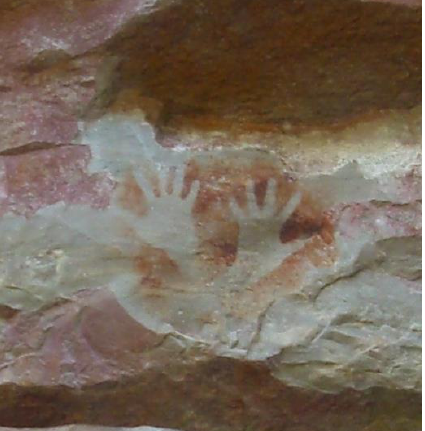
Figure 12. Paired stencils with thumbs outwards, Mt Borradaile,